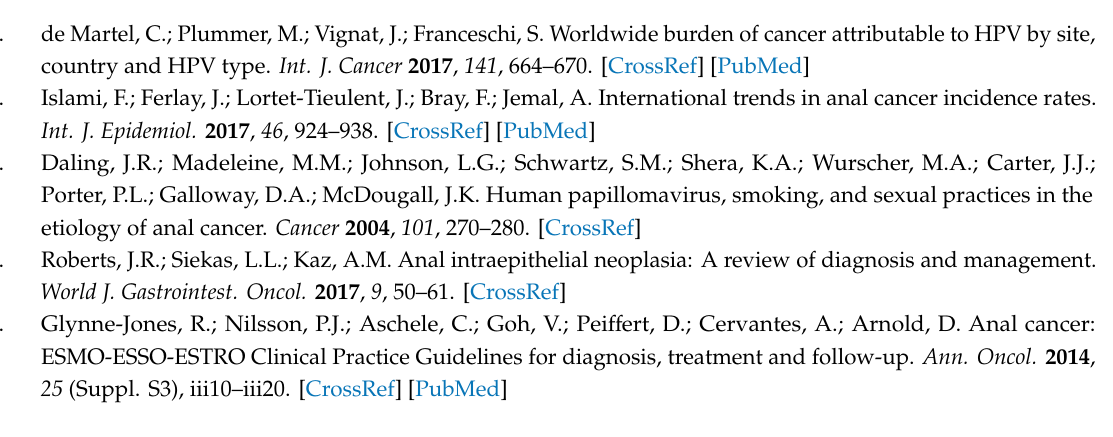
Table S1: Patients infected with multiple HPV